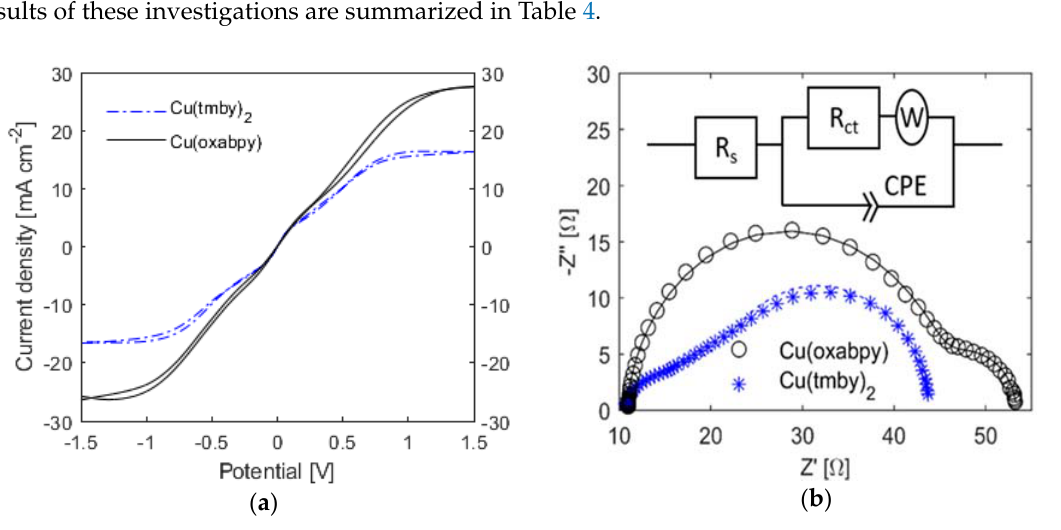
Figure 8. Electrochemical characterization of symmetrical PEDOT ‐ PEDOT cells with Cu(tmby) 2 and Cu(oxabpy) electrolyte. ( a ) Cyclic voltammetry (scan speed 25 mV/s); ( b ) Electrochemical impedance spectra recorded at zero ‐ potential; the circles indicate experimentally collected data points, dashed lines represent fits to the alternative circuit model (inset). Figures S10 and S11 and Table S2 include investigations for varying Cu I/II (oxabpy) electrolyte composition.